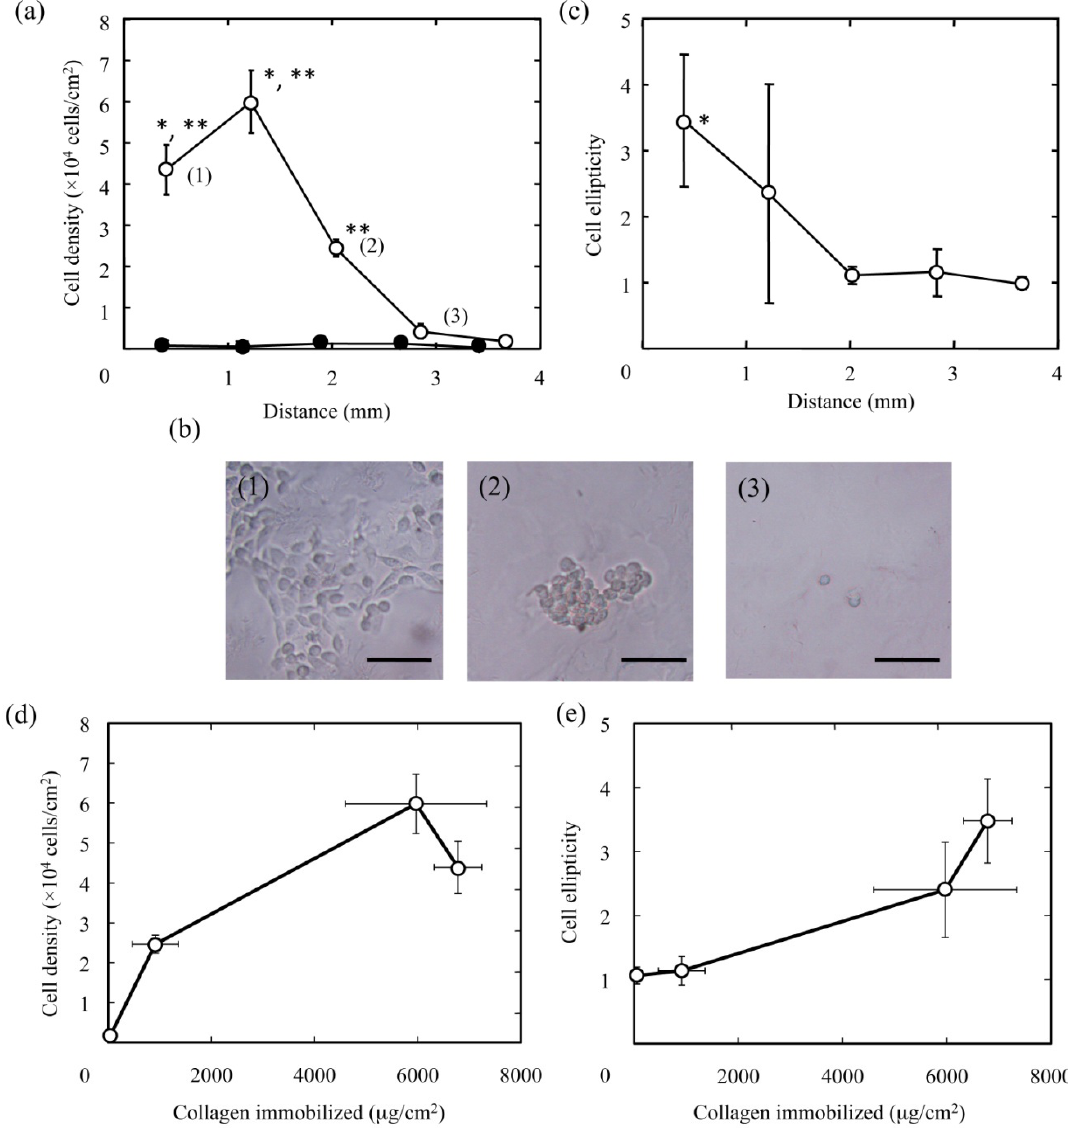
Figure 5. The attachment and morphology of L929 cells on PAAm hydrogels with a concentration gradient of type I collagen. (a) Effect of the concentration gradient of collagen immobilized in the PAAm hydrogel on the cell density. * p < 0.05; significance against the cell density of the plot (2) in the figure. ** p < 0.05; significance against the cell density of the plot (3) in the figure. (b) Phase contrast microscopic pictures of cells attached at the sites which correspond to the plots (1), (2), and (3) in Figure 5a. Bars correspond to 100 μ m. (c) Effect of the concentration gradient of collagen immobilized in the PAAm hydrogel on the cell ellipticity calculated by image analyses for the microscopic pictures of cells (Figure 5b). * p < 0.05; significance against the cell ellipticity at the site of 2 mm and longer in distance from the surface of hydrogel facing the NaOH solution. (d) Effect of the amount of type I collagen immobilized in the PAAm hydrogel on the cell density. (e) Effect of the amount of type I collagen immobilized in the PAAm hydrogel on the cell